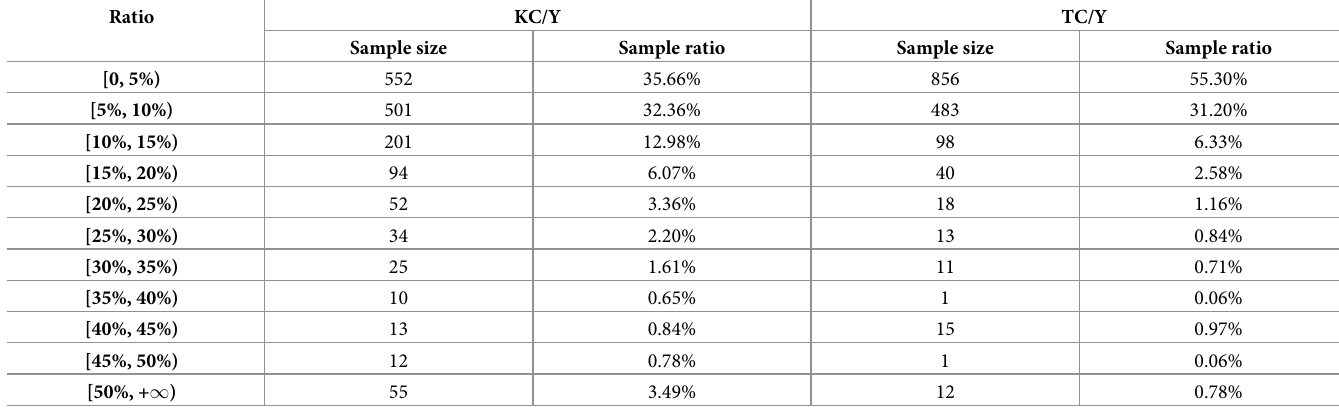
Table 2. Distribution of the proportion of knowledge capital and technology capital to operating revenue.